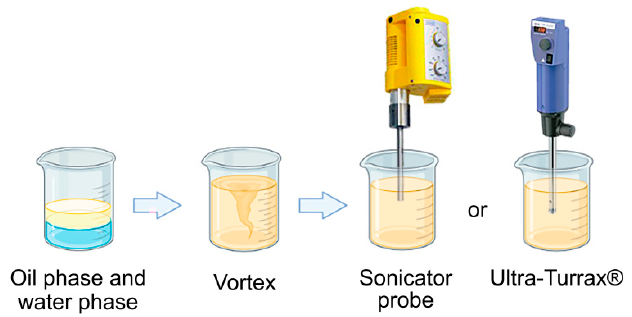
Figure 6. Schematic of o/w NE processing using high-energy methods.